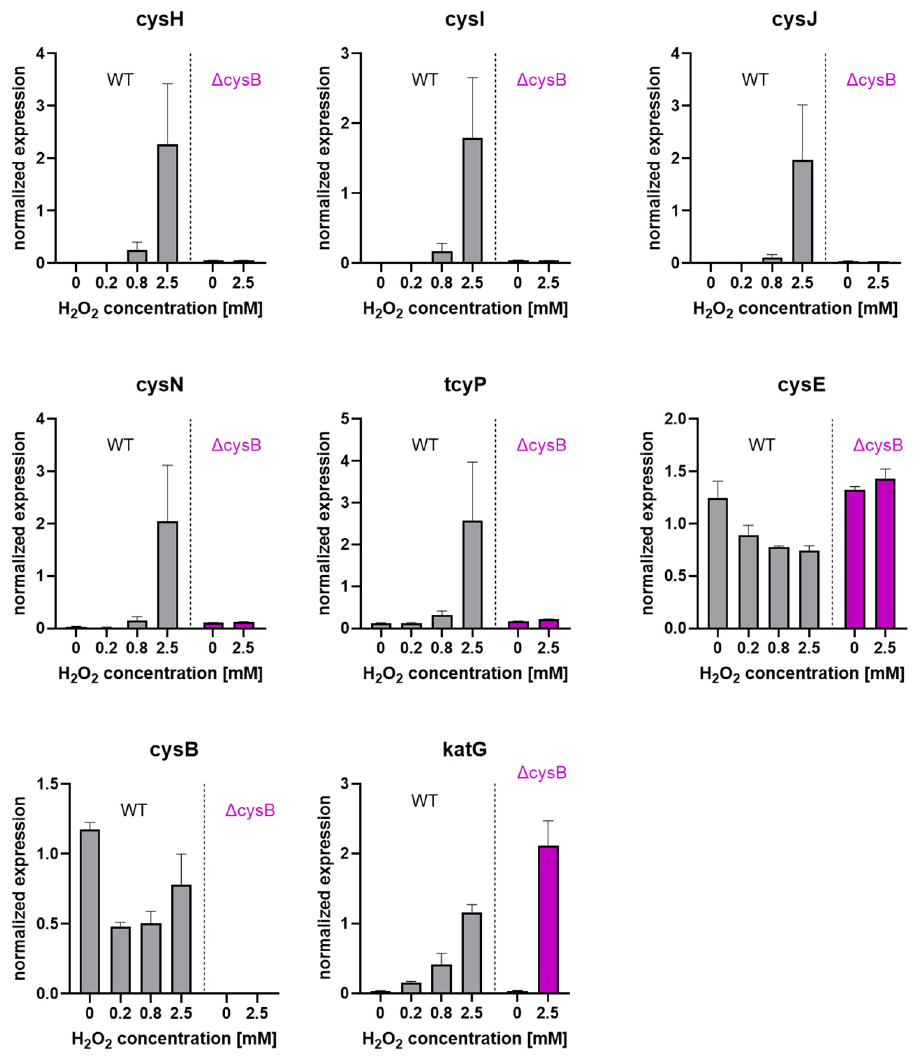
Figure 7. Expression of katG and sulfur metabolism-related genes ( cysB , cysE , cysH , cysI , cysJ , cysN. tcyP ) by qRT-PCR; the WT and the cysB deleted strain were exposed to the indicated concentrations of H 2 O 2 ( N = 3; mean +/ − SEM).